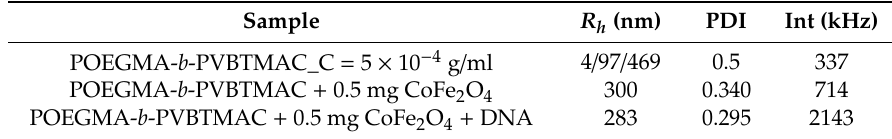
Figure 2. Comparison of the size distributions from Contin for the POEGMA- b -PVBTMAC diblock at different concentrations of NaCl at 90°. Table 3. DLS results for the POEGMA- b -PVBTMAC copolymer, MNPs–hybrid complexes and magnetopolyplexes ( N / P = 4) at 0.01 M NaCl.